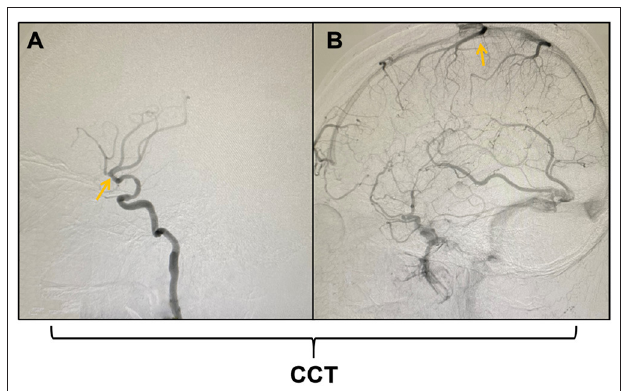
FIGURE 1 | Schematic diagram of the measurement of cerebral circulation time (CCT). (A) shows the appearance of the middle cerebral artery (MCA); (B) shows the peak intensity of the Trolard vein. The CCT was defined as the time from the appearance of the MCA to the peak intensity of the Trolard vein during digital subtraction angiography (DSA).